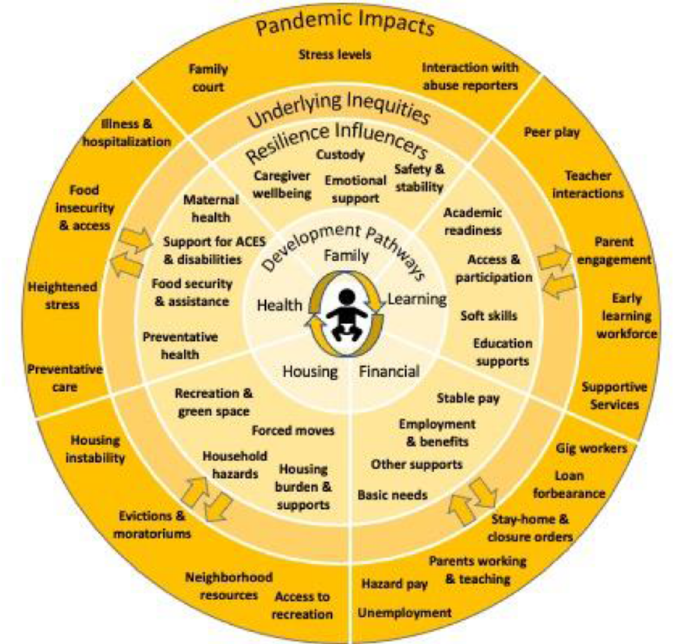
Figure 1: Conceptual data model of developmental resilience pathways